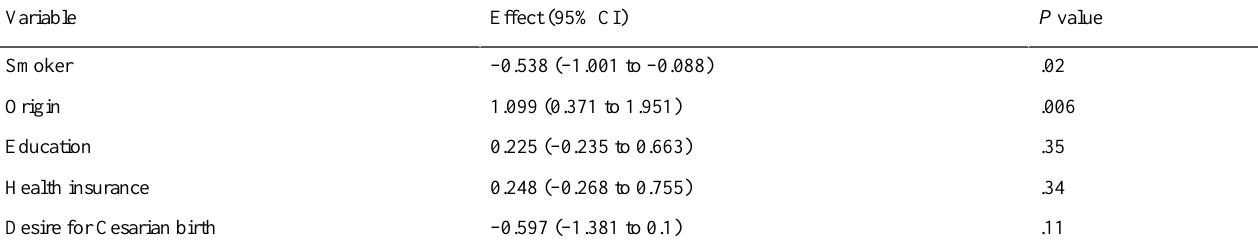
Table 5. Multivariate logistic regression on high